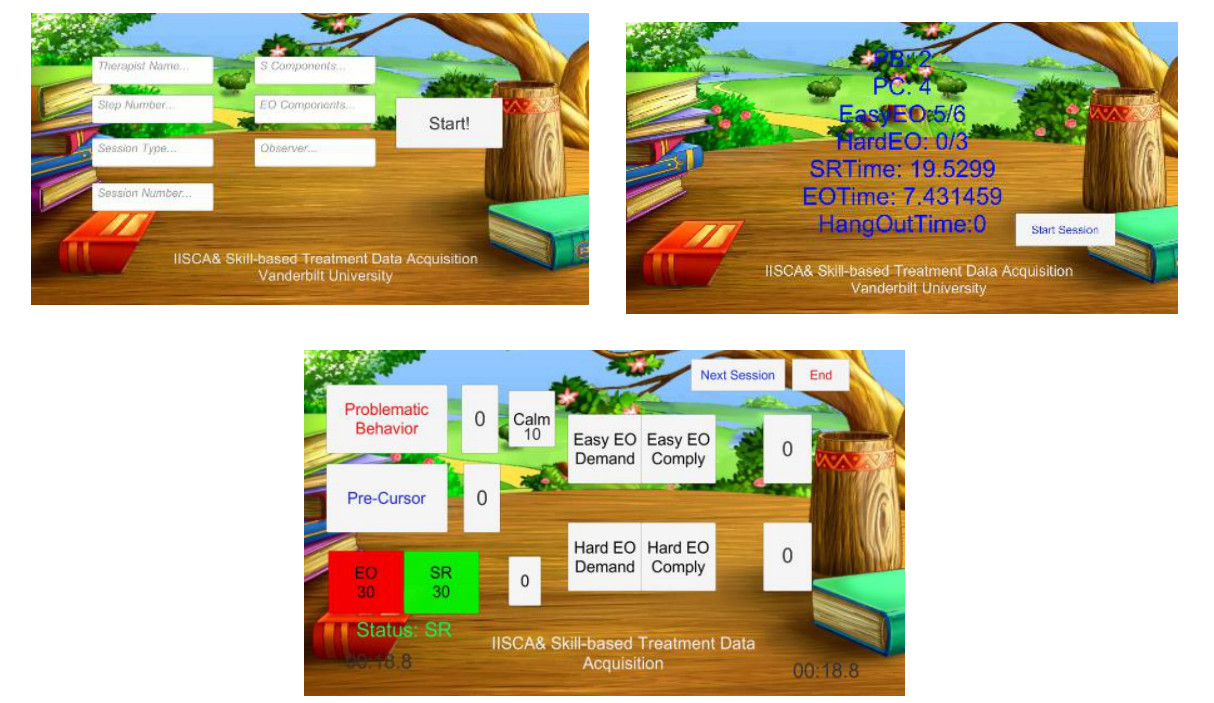
Figure 6. Screenshots of the Behavior Data Collection Integrator (BDCI) application.